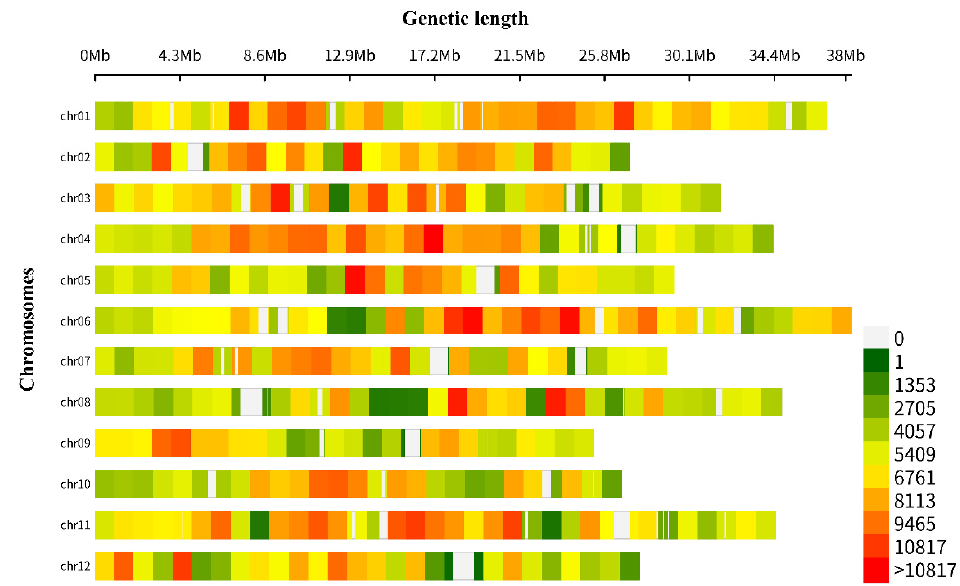
Figure 4. Total SNP variants detected within a 1-Mb window-sized chromosomal region of rese- quenced parental lines.